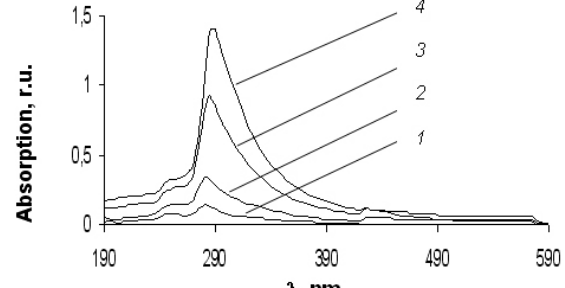
Figure 2. UV absorption spectra of PA treated in 0.1 mol dm -3 K